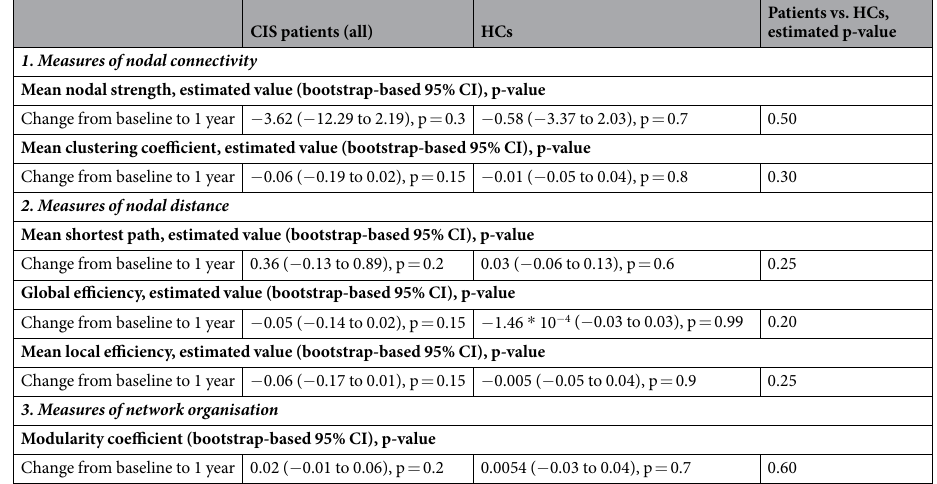
Table 2. One-year changes in SCN parameters, in CIS patients and HCs. Comparison between CIS patients and HCs was made looking at the 95% CI. See main text for full details on the methods used. Significant p-values are indicated with bold letters. Abbreviations: CI: confidence interval; CIS: clinically isolated syndrome; FU: follow-up; HCs: healthy